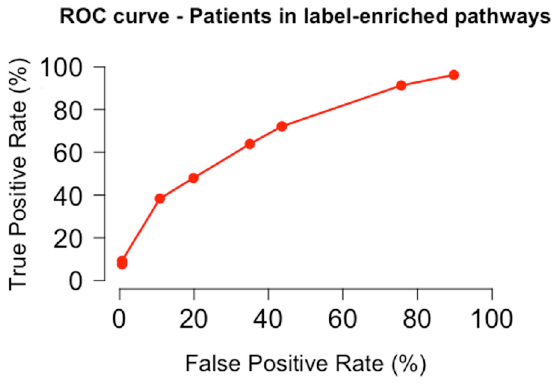
Figure 10. ROC curve for case-control classification in autism, using rare copy number variations (CNV) in pathway genes. In this design, patients are classified as cases if they carry a CNV in pathways passing feature selection, and controls otherwise. Each dot in the graph shows the sensitivity/specificity for a given cutoff for feature selection.